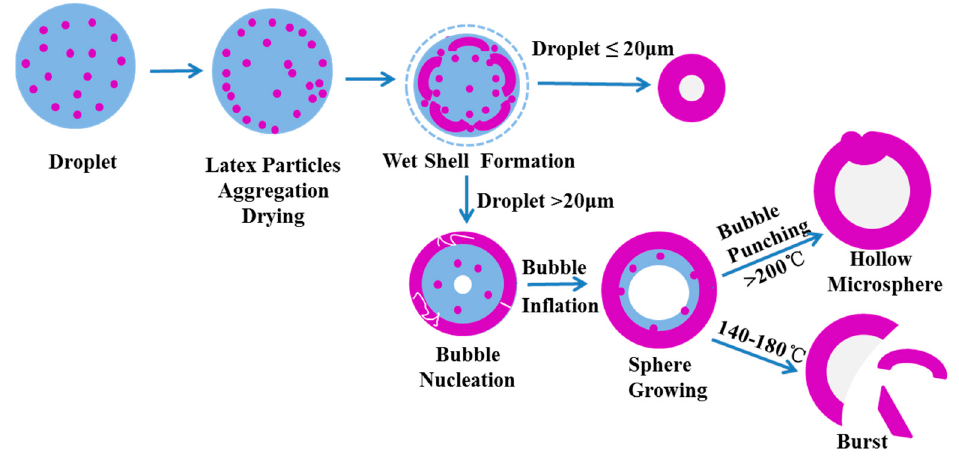
Figure 3. Formation mechanism of the polyacrylate hollow microspheres during centrifugal spray drying.